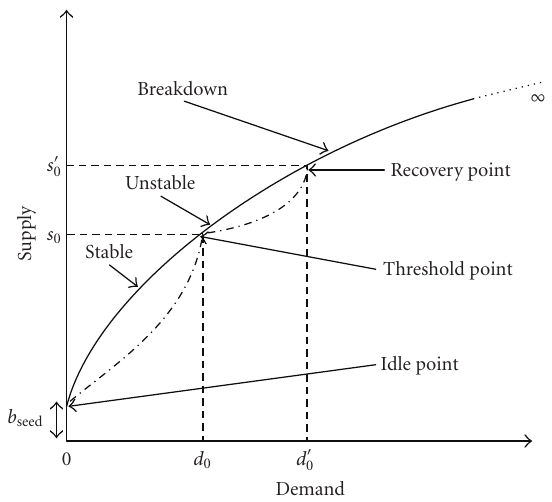
Figure 4: Remote microscopy system performance at di ff erent supply and demand